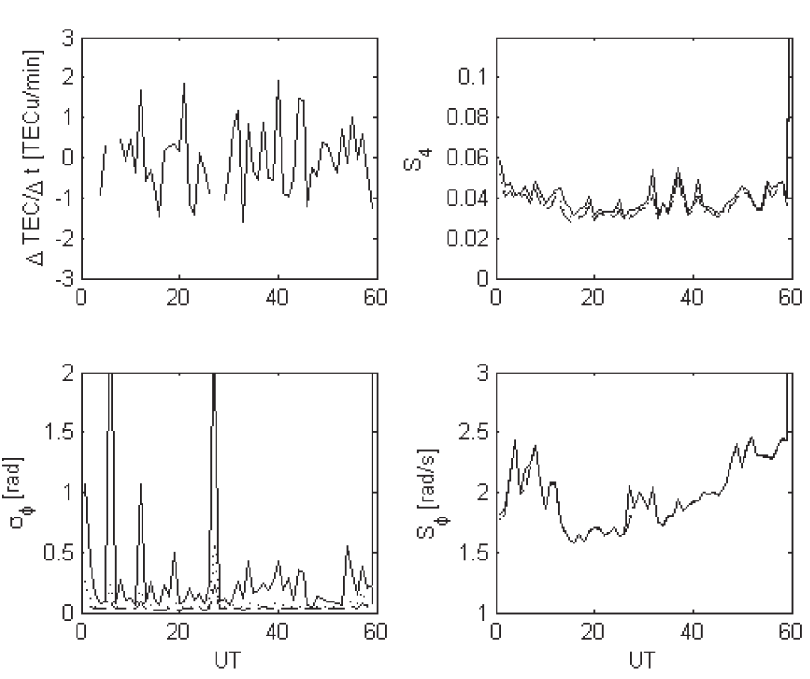
Fig. 18. TEC fluctuations and scintillation indices for PRN02 pass from 0700 to 0800 UT on the day